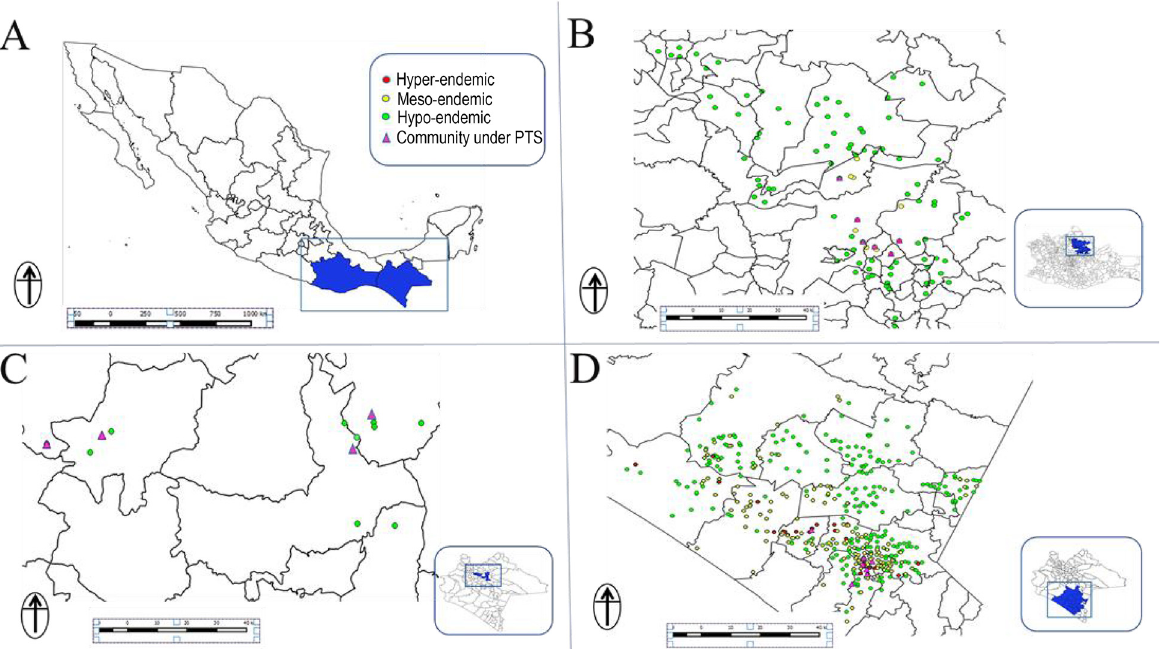
Fig 2. The onchocerciasis communities under post-treatment surveillance (PTS) phase in Mexico: Panel A: Map of the Southern Mexico states showing the two endemic States for onchocerciasis. A total of 98 communities were under PTS phase in the Oaxaca focus (Panel B). In addition, 13 and 559 communities were also under PTS phase in the Northern (Panel C) and Southern Chiapas foci, respectively (Panel D).